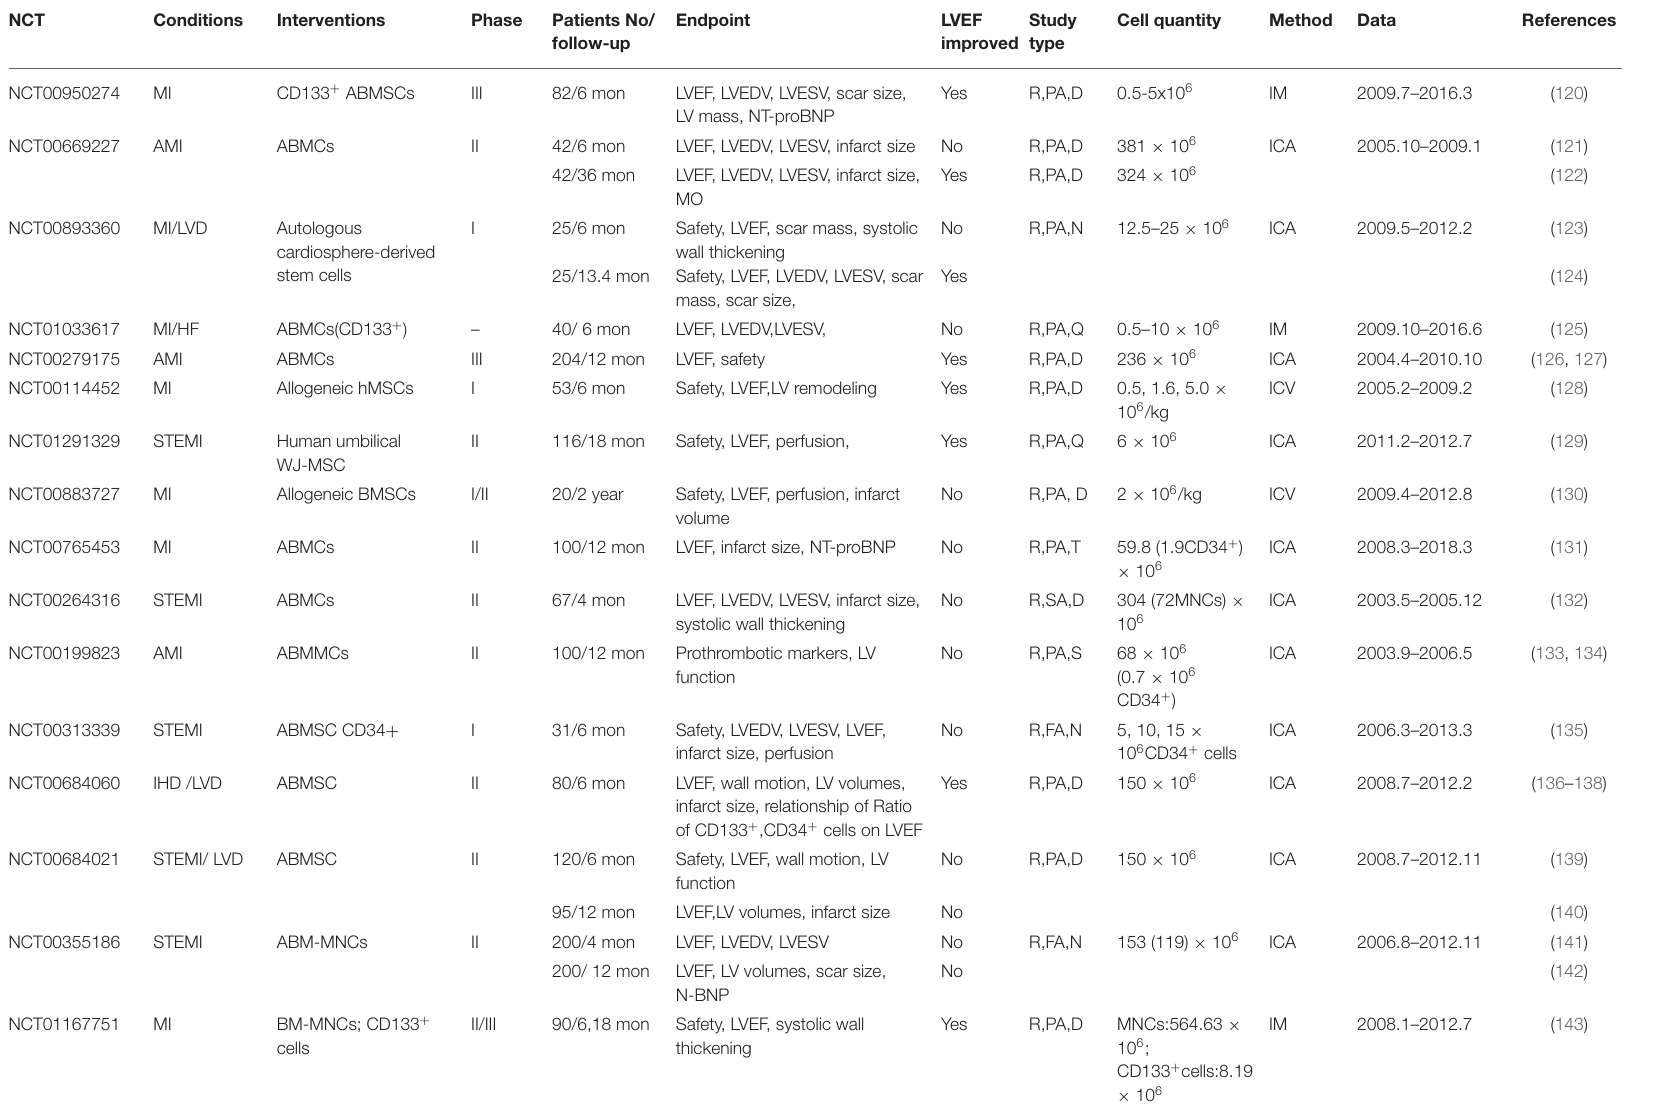
TABLE 2 | Completed clinical trials using MSCs to treat ischemic cardiovascular diseases registered at